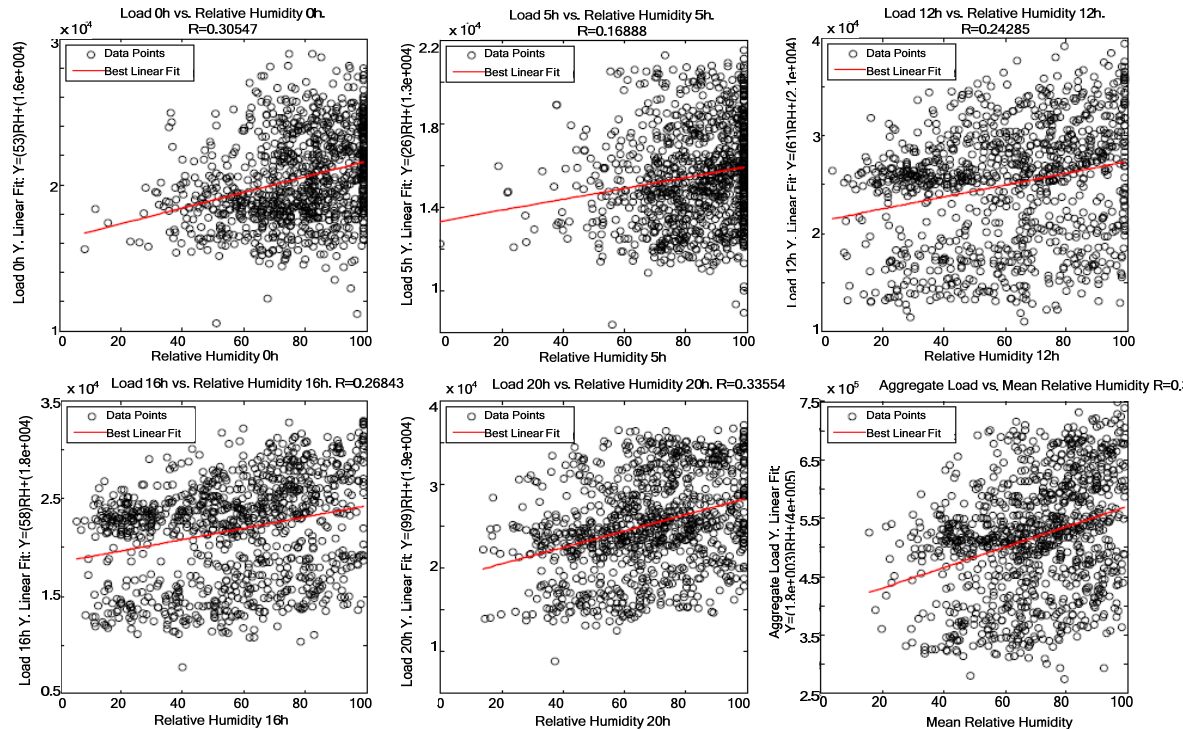
Figure 12. Correlations between average relative humidity and electric power consumption at 0 h, 5 h, 12 h, 16 h, and 20